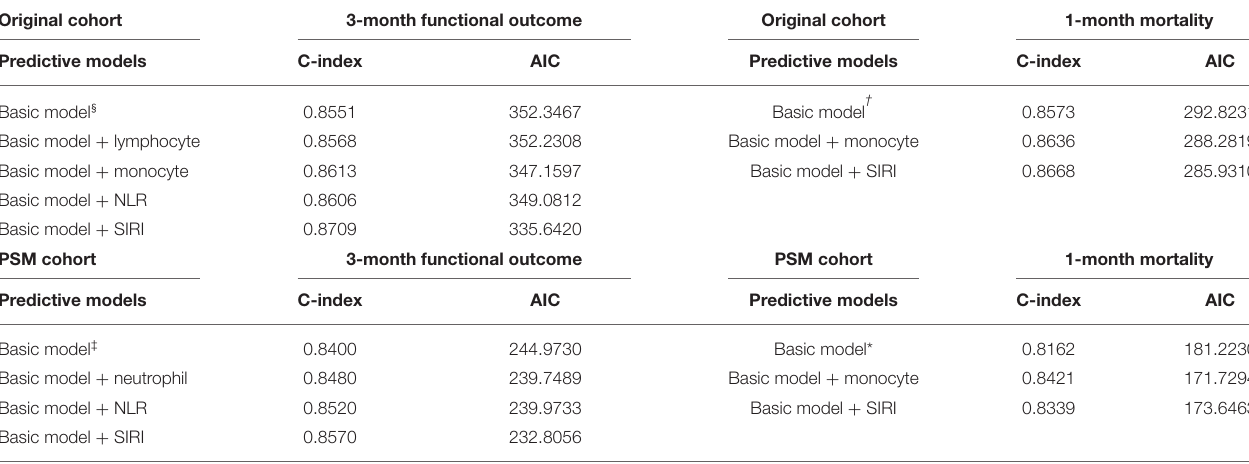
TABLE 5 | Predictive models for predicting primary outcomes of ICH patients.